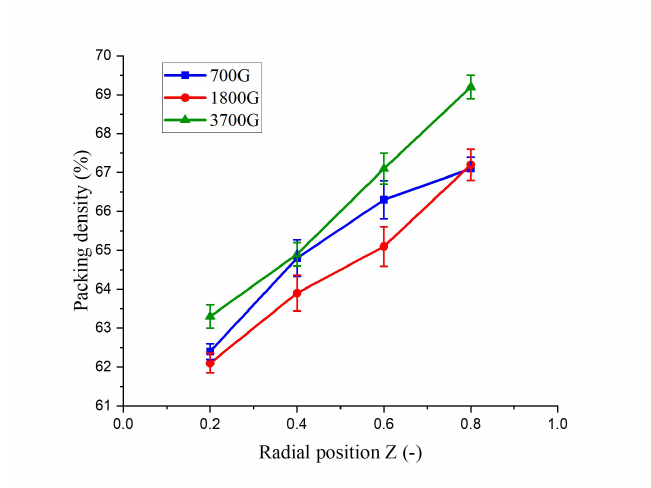
Figure 7. Radial distributions of packing density of green bodies prepared at various centrifugal forces.